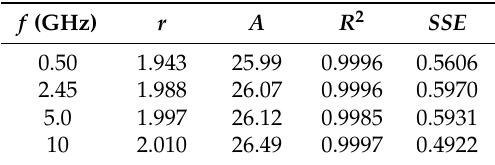
Table 9. Regression coefficients (with 95% confidence bounds) and goodness-of-fits for Equation (12).